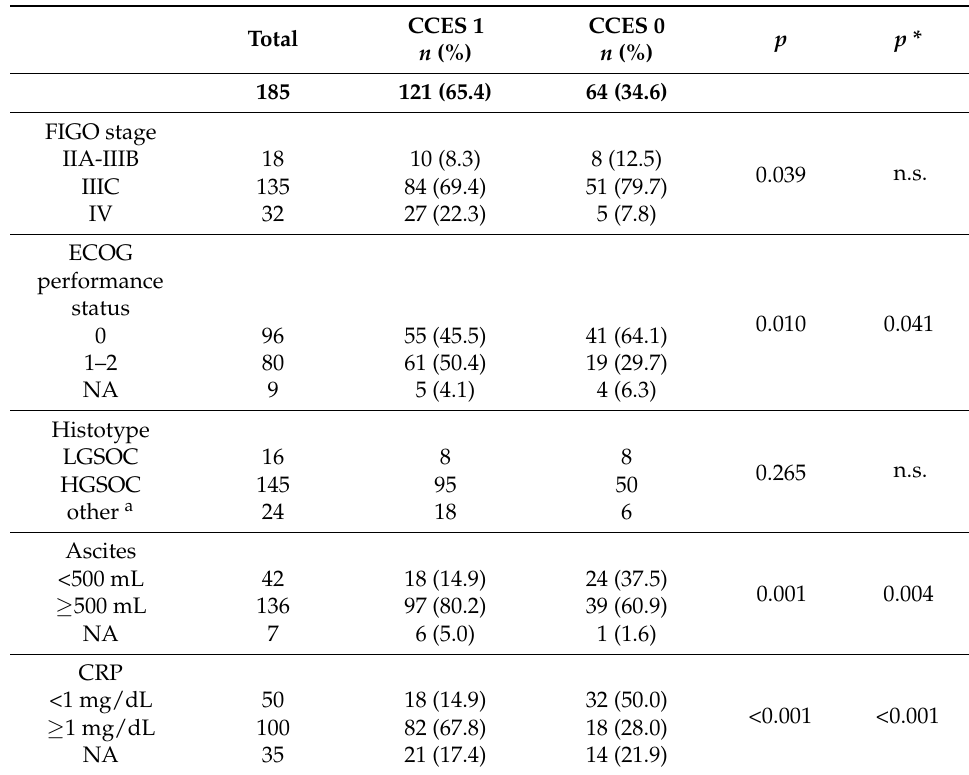
Table 2. Association of the combined cancer exhaustion score (CCES) with patients’ characteristics. Patients with hypoalbuminemia or a high Kyn/Trp ratio were assigned to the CCES 1 group, and those with normal albumin and low Kyn/Trp to the CCES 0 group. Pearson’s chi-square was used to assess the association of each parameter and CCES. LGSOC, low grade serous ovarian cancer; HGSOC, high grade serous ovarian cancer; a clear cell ( n = 2), endometrioid ( n = 7), mixed epithelial ( n = 7), undifferentiated ( n = 8). NA not assessed. * Bonferroni corrected p